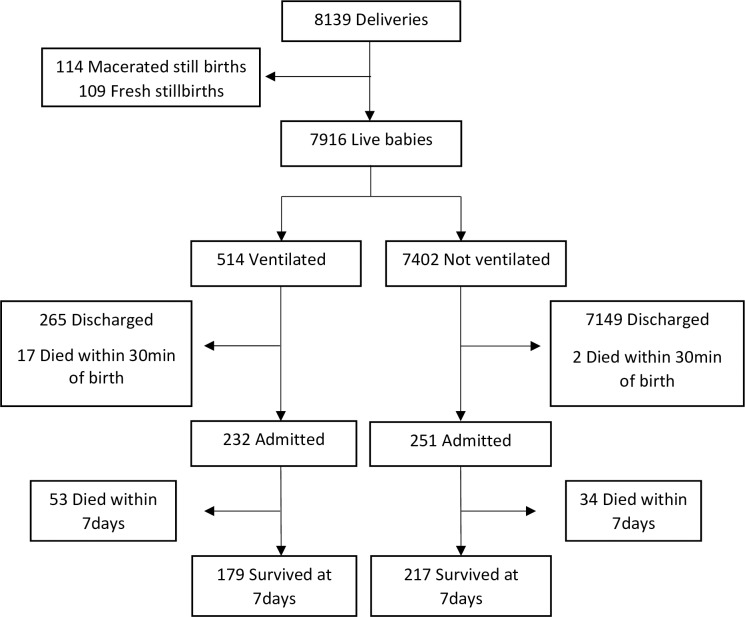
Flow diagram of patient recruitment.